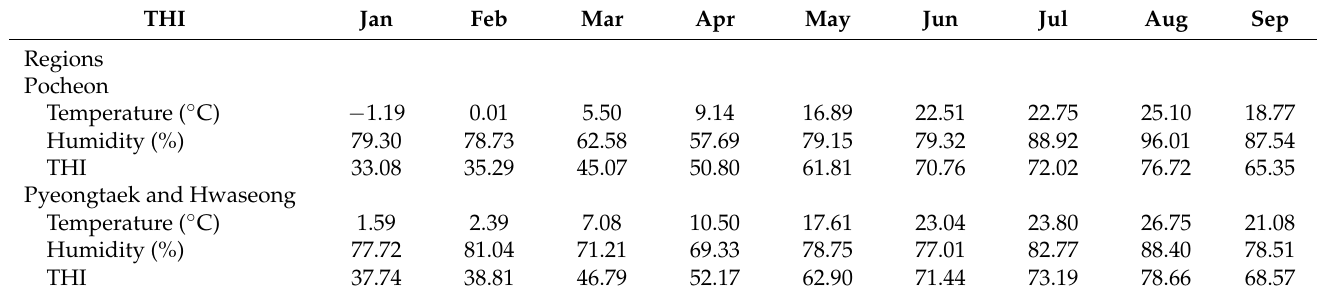
Table 1. Observed mean monthly temperature–humidity index (THI) based on the data from the year 2020 of the Korea Meteorological